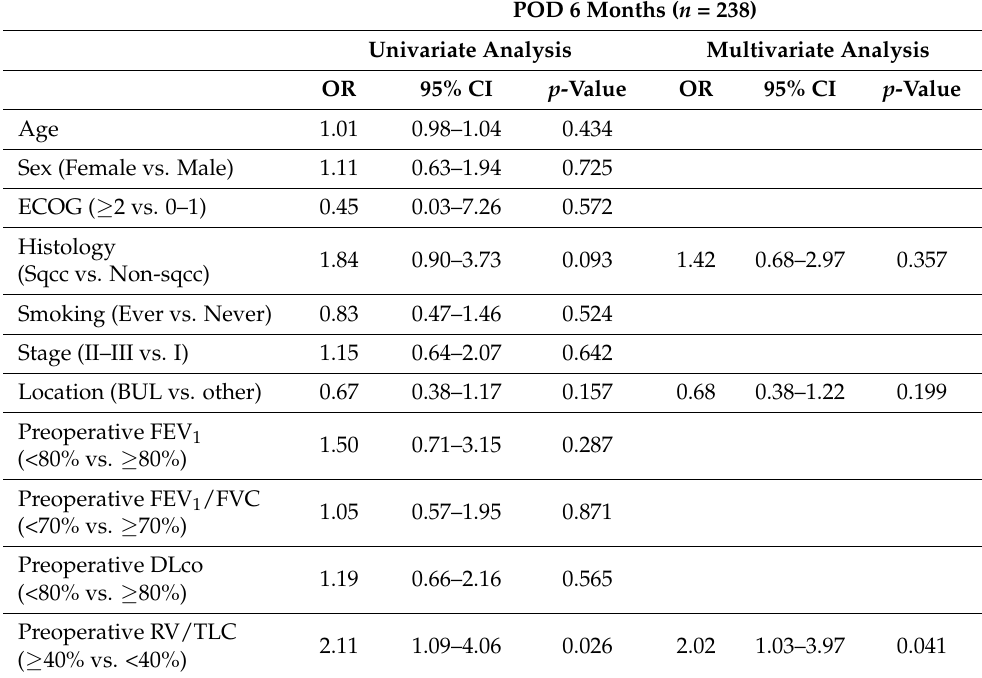
Table 3. Factors associated with preserved postoperative FEV 1 .